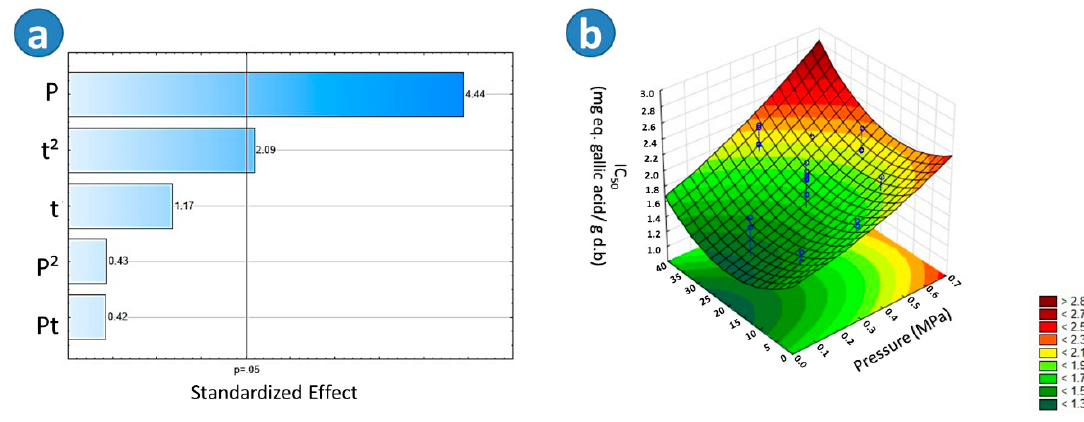
Figure 6. The effects of steam pressure “P” (MPa) and thermal processing time “t” (s) on the free radical scavenging activity by DPPH (IC 50 ) of Blanched Swell-Dried (BSD) red beetroots. ( a ) The Pareto chart and ( b ) surface response plot are shown.